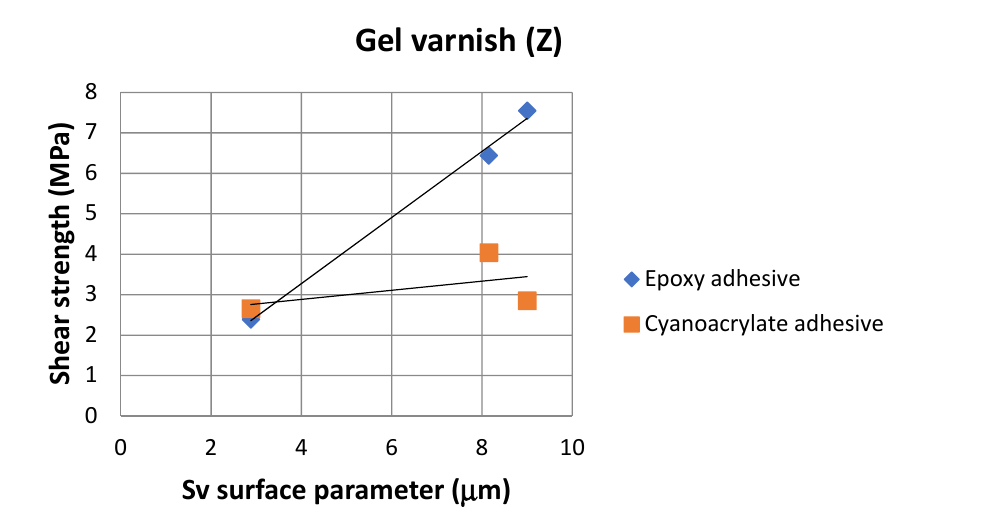
Figure 9. Relations between adhesive joints shear strength with gel varnish (Z) and the Sv surface roughness parameter.